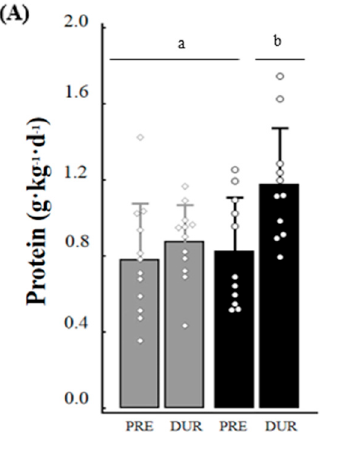
Table 2. Intake of calories, macronutrients, and BCAAs according to moments and groups.